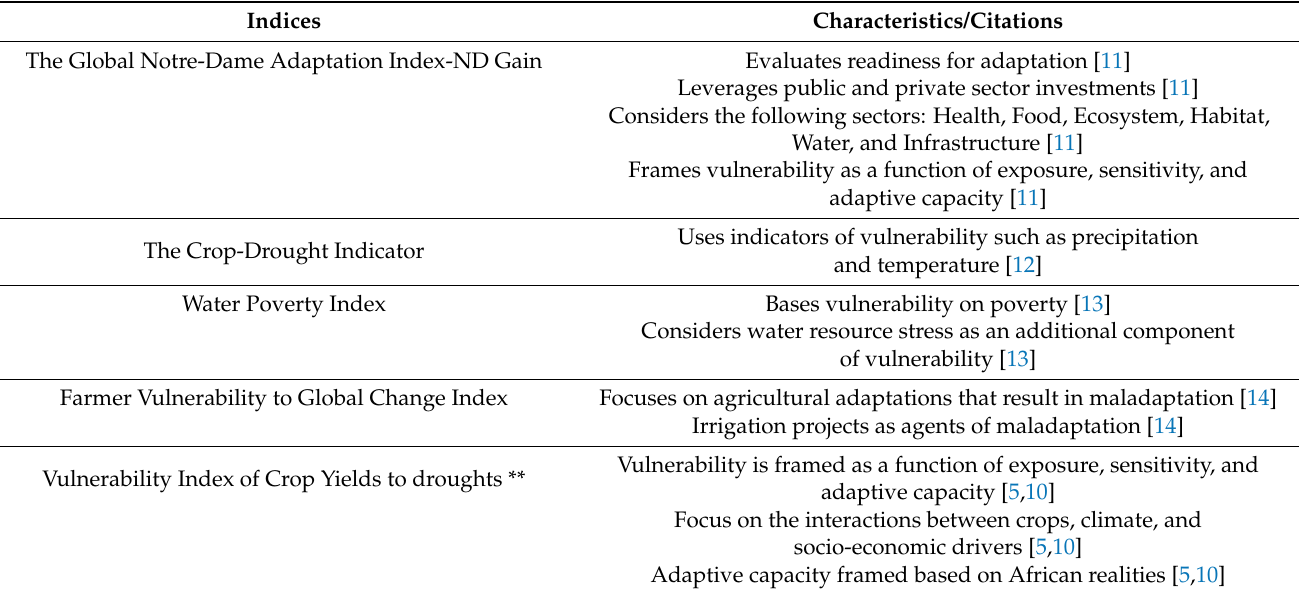
Table 1. Other vulnerability